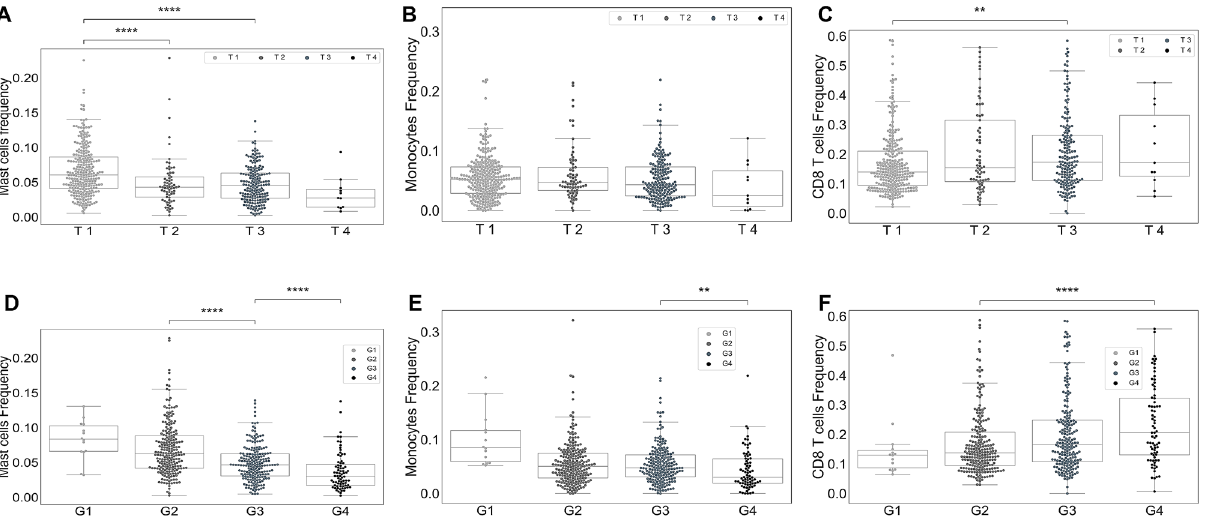
Figure 3. Percentage of mast cells, monocytes and CD8+ T-cells in ccRCC tumors as a function of grade and TNM staging. Sub-figures ( A )–( C ) show the percentages of mast cells ( A ), monocytes ( B ), and CD8+ T-cells ( C ) in primary tumors as a function of stage of tumors. Sub-figures ( D )–( F ) represent the percentage of mast cells ( D ), monocytes ( E ), and CD8+ T-cells ( F ) in primary tumors as functions of the grade of tumors.